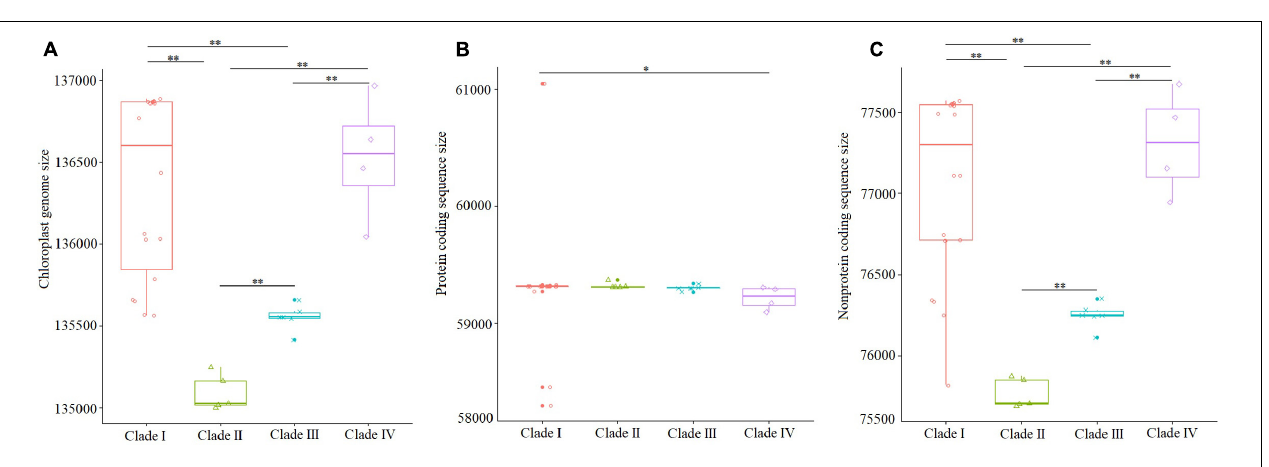
FIGURE 6 | Comparisons of complete cp genome, protein coding region, and non-protein coding region within the four clades, with significant differences ( p < 0.05, Kruskal–Wallis test) being estimated. (A) Comparisons of complete cp genome sequences; (B) comparisons of protein coding gene sequences; (C) comparisons of non-protein coding sequences. * p < 0.05; ** p <